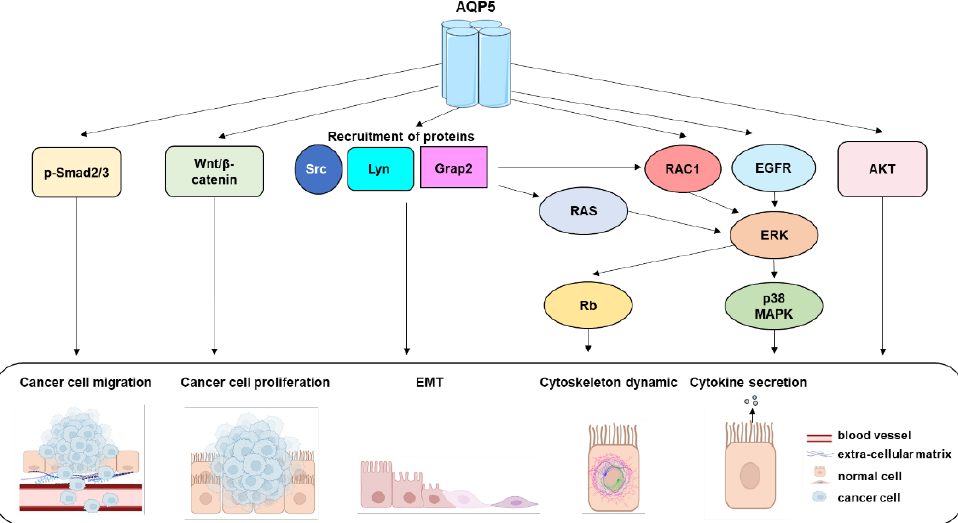
Figure 4. Downstream effectors of AQP5. AKT: Serine-Threonine Protein Kinase; EGFR: epidermal growth factor receptor; EMT: epithelial-mesenchymal transition; ERK1/2: extracellular receptor ki- nase; Grap2: GRB2 Related Adaptor Protein 2; Lyn: Lyn protooncogene; p38 MAPK: p38 mitogen- activated protein kinase; RAC1: Rac family of small GTPase 1; Ras: RAS superfamily of small GTP- binding proteins; p-Rb: phosphorylated retinoblastoma protein; p-Smad2/3: phosphorylated-moth- ers against decapentaplegic homolog 2 /3; Src: Src protooncogene; Wnt: Wingless/Integrated.